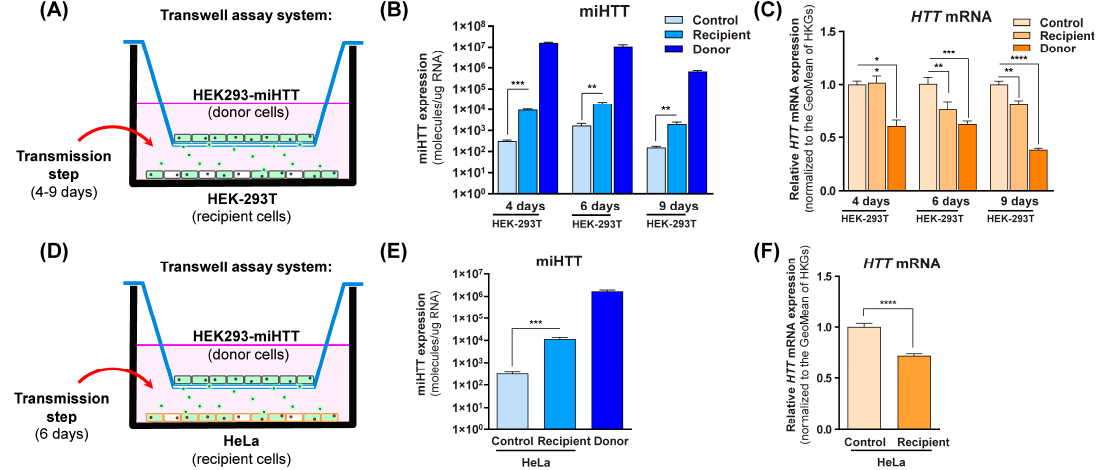
Figure 3. Engineered miHTT is transferred from donor to recipient cells and lowers HTT mRNA levels. ( A , D ) Schematic description of contactless transwell assay employing both HEK-293T and HeLa cells. ( B ) Contactless transwell assay temporal study of miHTT transfer from the miHTT-over expressing donor cell line to recipient HEK-293T cells at 4, 6, and 9 days of co-culture; ≥ N = 6 repeats per experimental condition, and ( C ) the resultant lowering of HTT mRNA; ≥ N = 6 repeats per experimental condition. ( E ) Contactless transwell assay study of miHTT transfer from the miHTT- overexpressing donor cell line to recipient HeLa cells at 6 days; ≥ N = 6 repeats per experimental condition and ( F ) the resultant lowering of HTT mRNA at 6 days; ≥ N = 6 repeats per experimen- tal condition. miHTT detection and HTT mRNA expression were assessed using RT-qPCR. Geo, geometric; HKGs, housekeeping genes. (* p < 0.02, ** p < 0.01, *** p < 0.001, **** p <